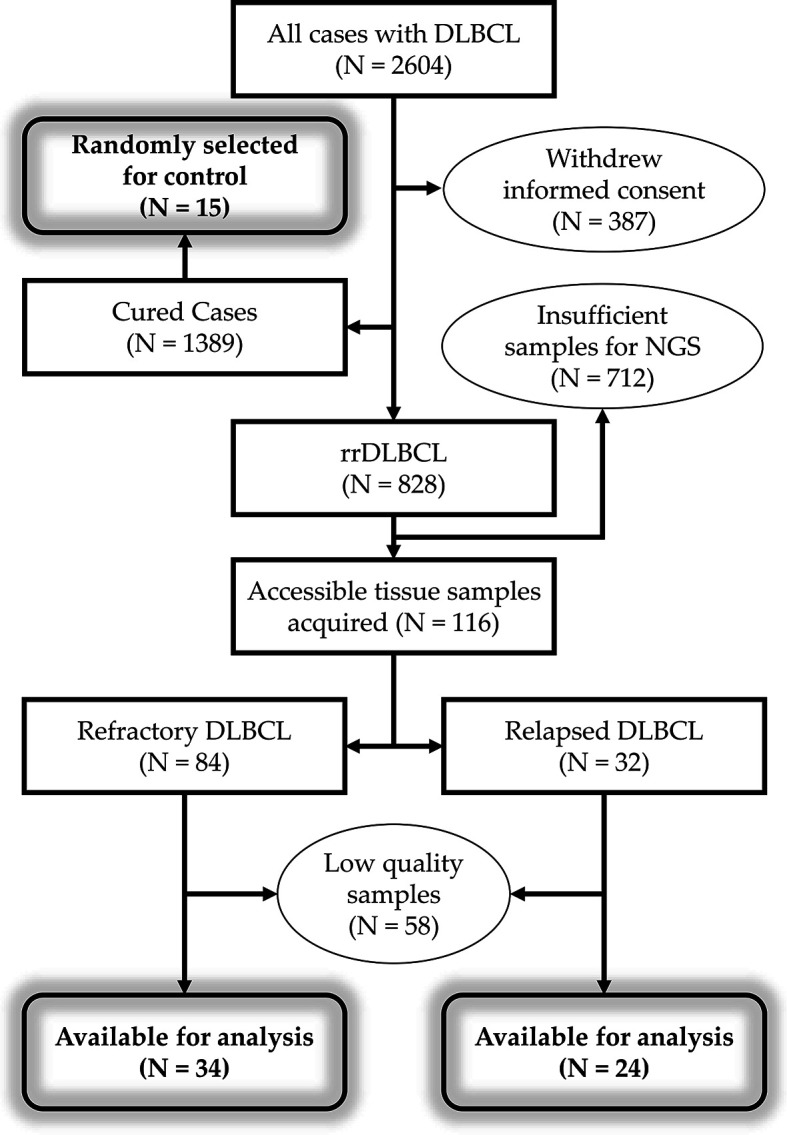
Workflow of patient selection. Total of 2,604 patients were diagnosed with DLBCL. Of the 2,217 patients with informed consent to review of medical records, 828 patients have refractory or relapsed disease. DNA extraction was performed using samples from 116 patients with rrDLBCL, but samples from 58 patients failed to pass the quality control. DLBCL, diffuse large B-cell lymphoma; rr, refractory/relapsed; NGS, next-generation sequencing.